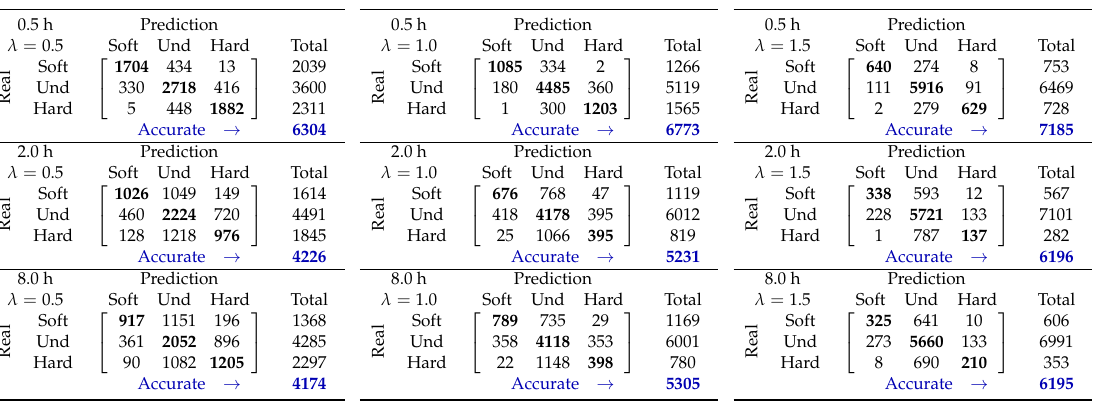
Table 5. SAG mill 2. Confusion matrices (number of instances) of ORH predictions using λ : 0.5, 1.0 and 1.5 at 0.5, 2 and 8 h time